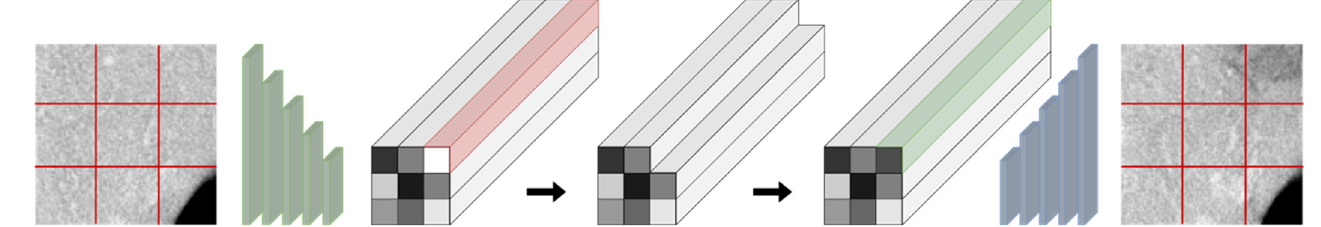
Figure 2. Schematic for latent code manipulation. Each shown CT patch is 96 × 96 pixels in size, corresponding to an approximate physical size of 96 × 96 mm.